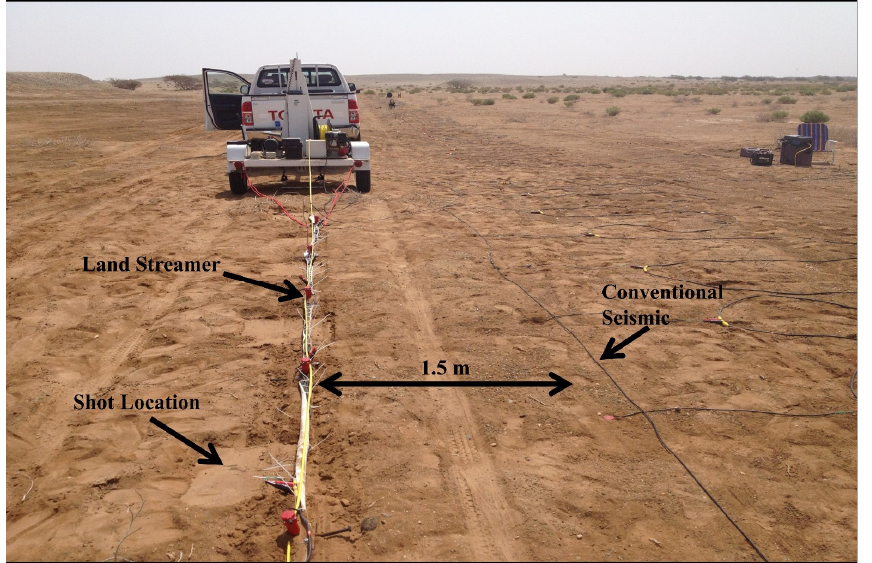
Figure 2. A photo of the data recording process shows the land-streamer, the conventional profile, and the weight-drop used as seismic source.